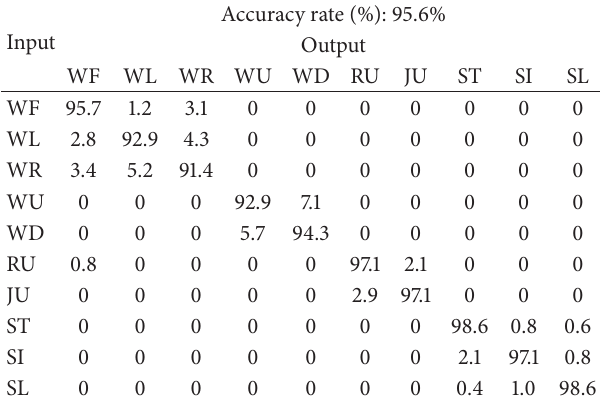
Table 4: Confusion matrix for average recognition accuracy for all